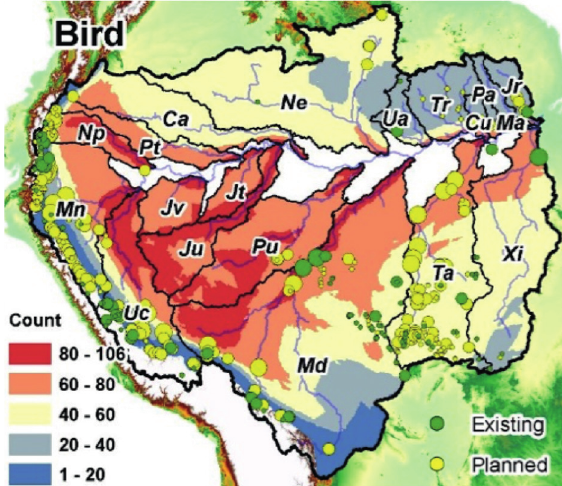
Figure 3 - Flooded habitat birds (non-aquatic) species richness patterns of Amazonian river basins. Color scale from blue (low) to red (high) represent the number of species. Number of species based on overlapping distributions of each single species. green and yellow circles are location of dams. Figure from latrubesse et al. (2017). Amazon’s 19 sub-basins are labeled with abbreviations: Andean-foreland Rivers: Marañon ( Mn ), Ucayali ( Uc ), Napo ( Np ), Putumayo ( Pt ), Caqueta ( Ca ); Cratonic rivers: Jari ( Jr ), Paru ( Pa ),